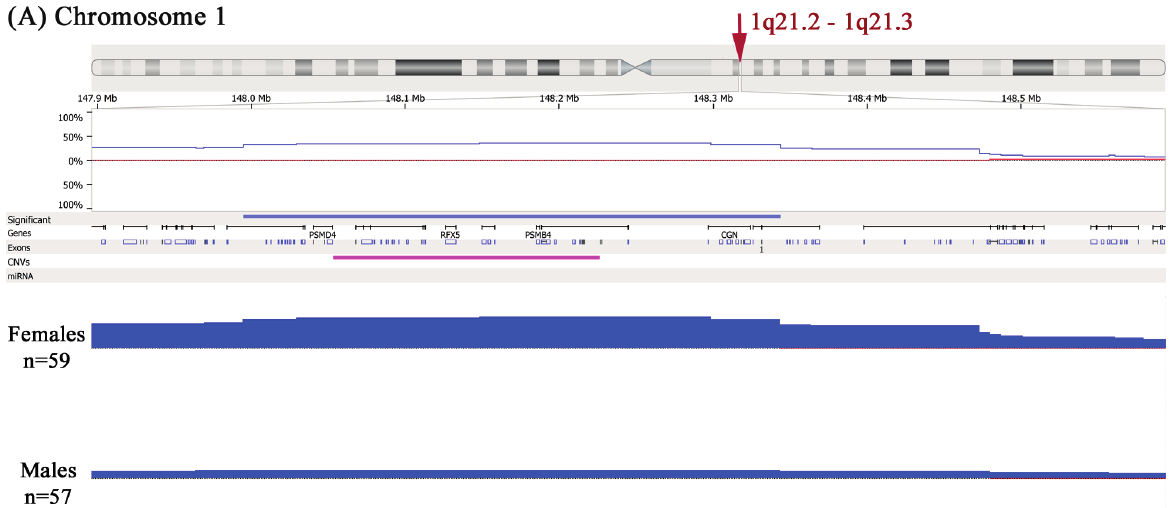
Figure 1. aCGH analysis of 116 colorectal cancers showing chromosomal copy number aberrations in male and female patients. Gains are depicted in blue and deletions in red. ( A ) 1q21.2–q21.3 locus; ( B ) 4q13.2 locus; ( C ) 6p21.1 locus; ( D ) 11q25 locus; ( E ) aCGH analysis using GISTIC algorithm showing copy number profiles of the autosomes and X-chromosome. The grey bars indicate highly significant aberrations as detected by GISTIC. Asterisks (*) indicate CNAs previously obtained by Significance Testing for Aberrant Copy number (STAC) then confirmed here. Black circles indicate statistically significant CNAs observed in females only, while arrowheads pinpoint CNAs specific to